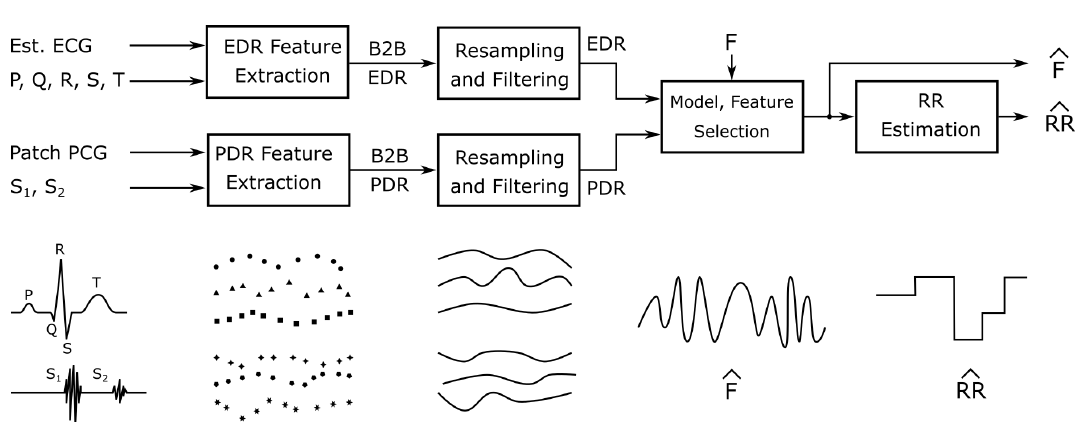
Figure 7. Beat-to-beat (B2B) ECG and PCG derived respiration for estimating the respiratory flow ˆ F and rate ˆ RR using the estimated ECG and the PCG signals in a model and feature selection